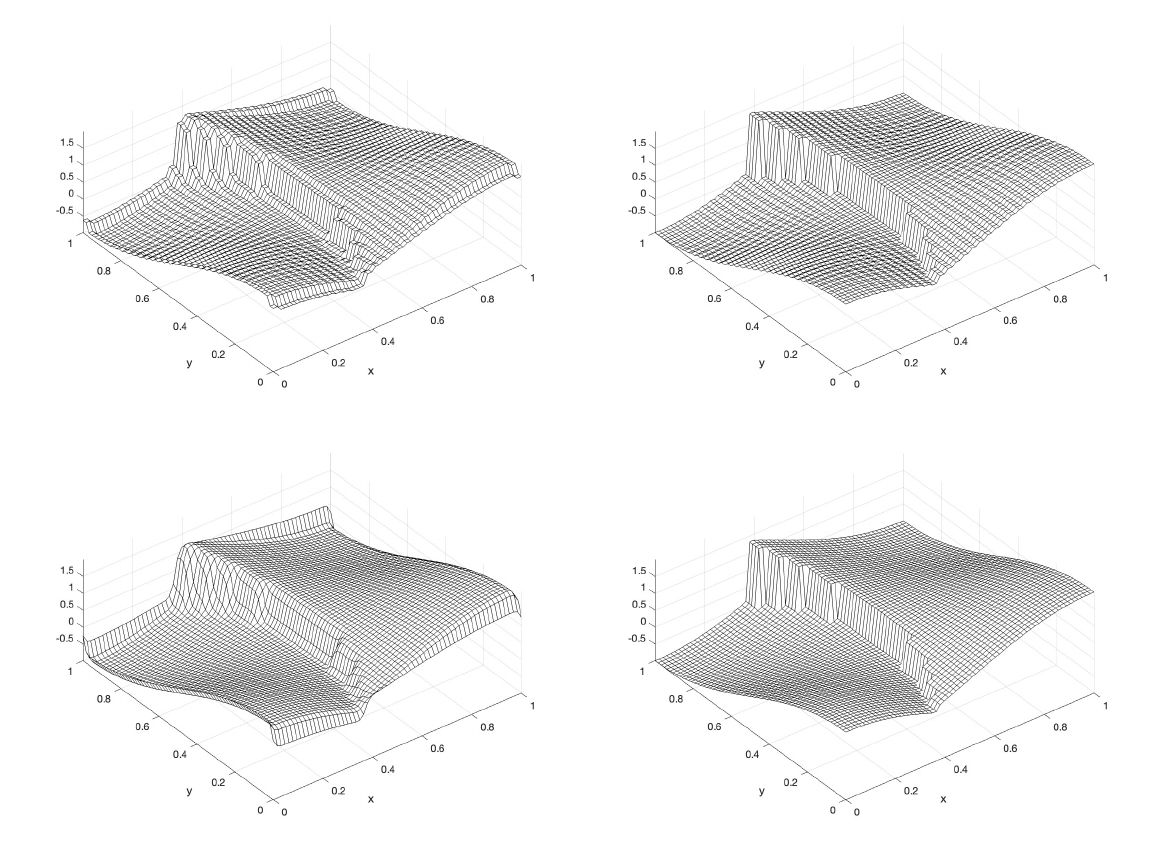
Figure 5. Top, subdivided data using w = 0.5 and one scale of subdivision. Bottom, subdivided data using w = 1 √ and one scale of subdivision. To the left, linear algorithm and to the right non 2 linear